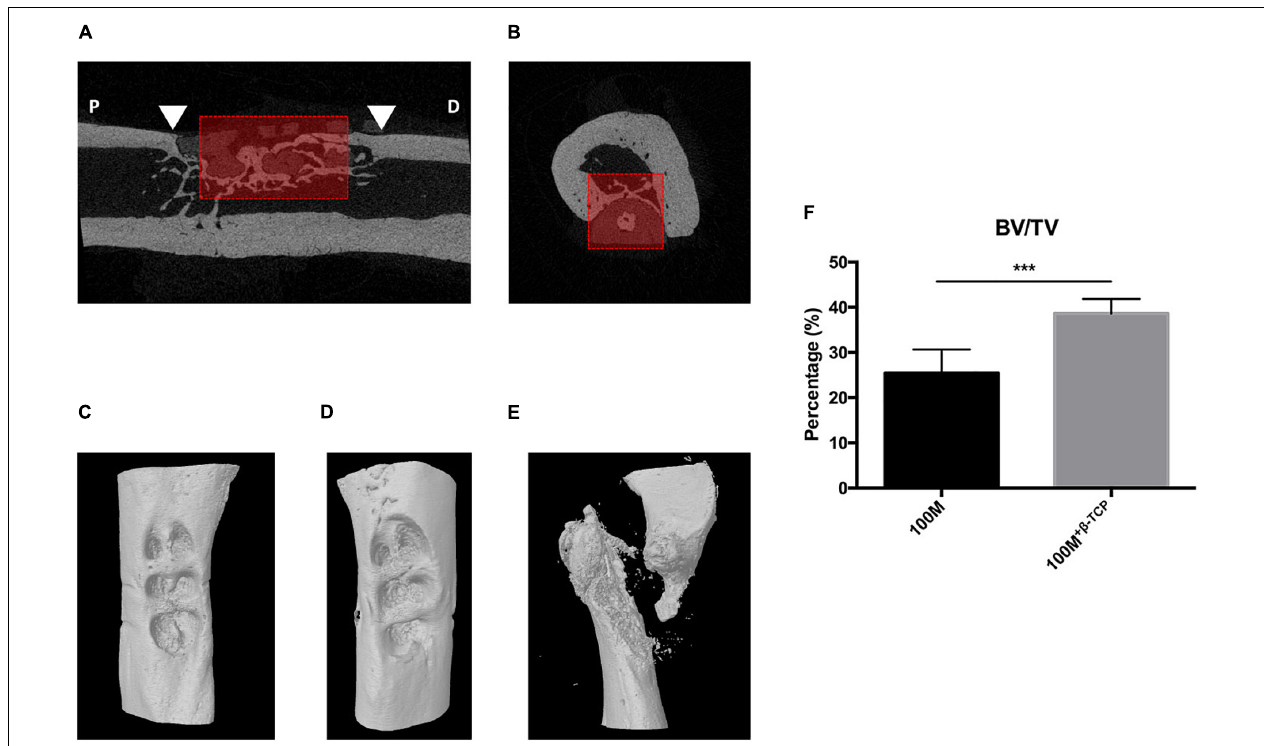
FIGURE 8 | µ CT ROI selection. A ROI measuring 4 mm long × 2 mm wide × 2 mm deep was delineated in the middle of the scaffold implant area (red box). Mineralized tissue and the scaffold were segmented by using different threshold values. Mineralized tissue content was quantified in the ROI. Arrowheads in (A) represent the edge of the defect, P: proximal, D: distal, dashed line represents the trans-axial section in (B) . (C) Reconstructed image representing defect area after 6 weeks implantation with 100M + β - TCP . (D) Reconstructed image of the defect area after 6 weeks of 100M implantation. (E) Reconstructed image of fractured femur implanted with 100M scaffold. (F) µ CT quantitative analysis of (BV/TV) ( n = 8), error bars represent ± SD, and *** P -value < 0.001.